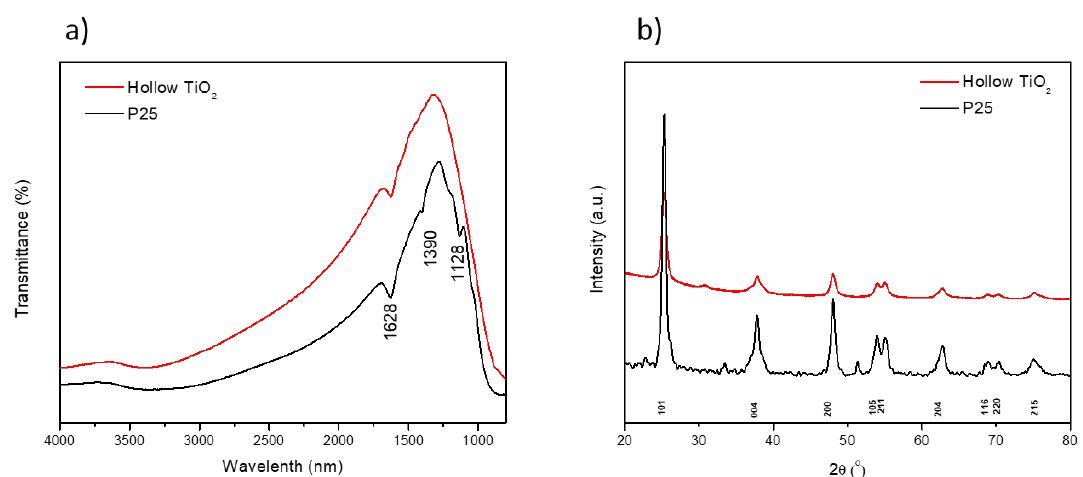
Figure 3. ( a ) FTIR of P25 powder and TiO 2 hollow powder. ( b ) XRD patterns for the P25 and TiO 2 hollow